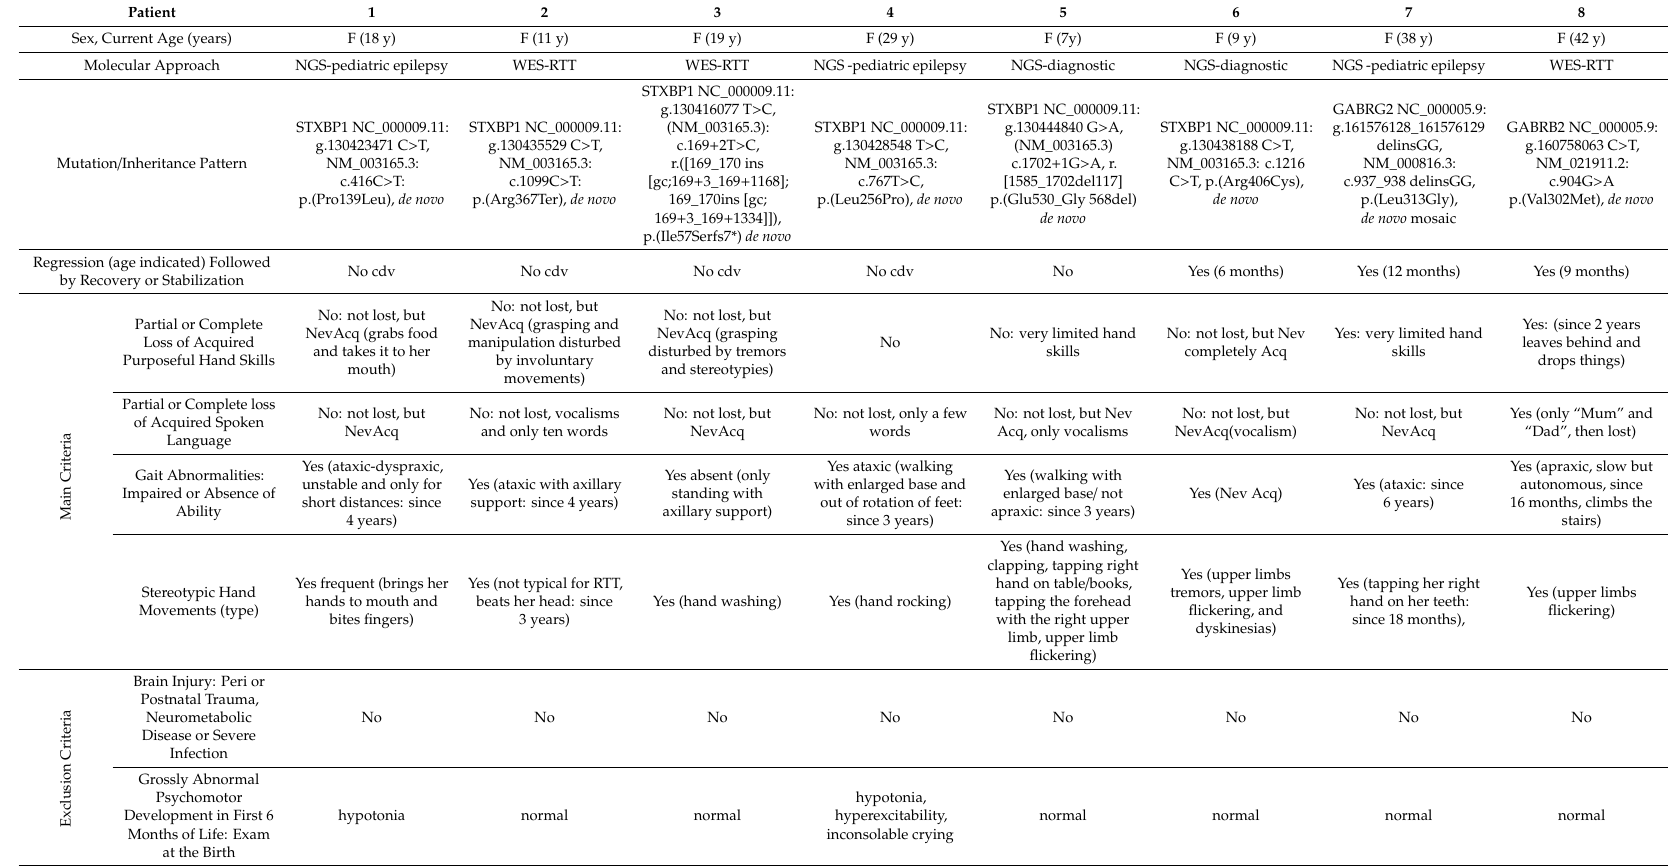
Table 1. Patient’s clinical features grouped according to Neul classification, the pathogenic variants and the Next generation sequencing (NGS) approach. Patient Sex,CurrentAge(years) WES-RTT